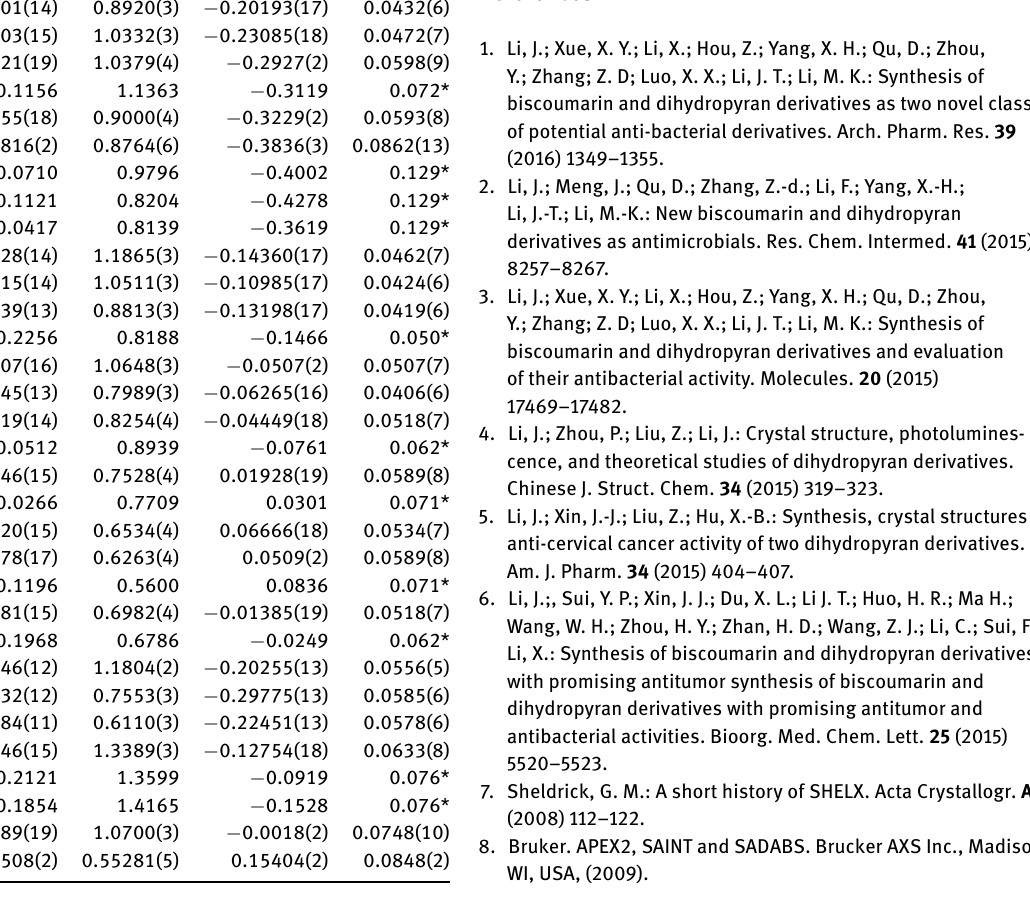
plane of the heterocyclic moiety is almost perpendicular to the mean plane of the bromophenyl substituent ( cf . the